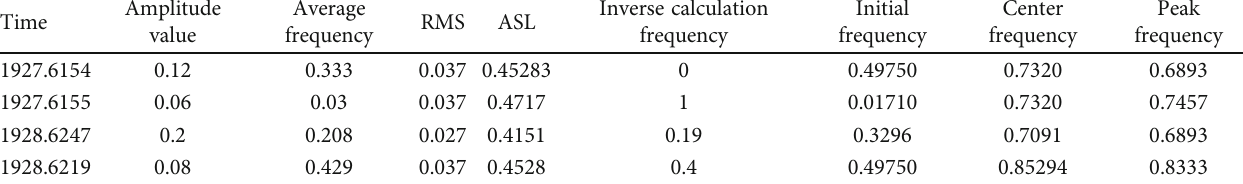
Table 2: Corresponding serial numbers of di ff erent frequency